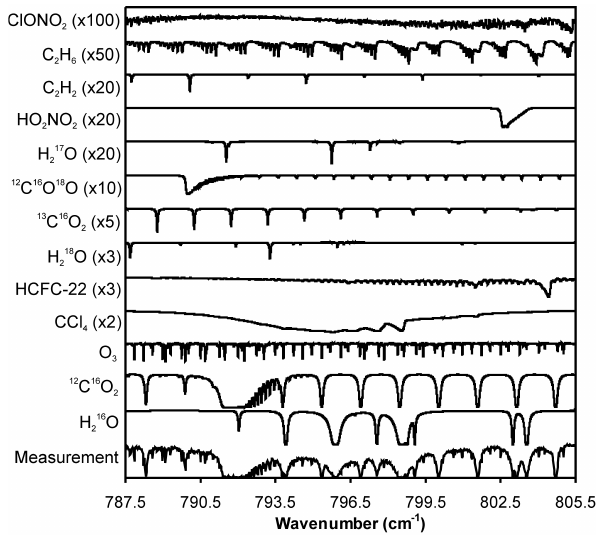
Fig. 1. The species which contribute to the spectral window in which carbon tetrachloride is retrieved. Weaker absorbers have been magnified and the baseline is offset in the vertical direction for clar- ity. The plot corresponds to the measurement (bottom panel) at a tangent height of 8.3km in tropical occultation ss11613.